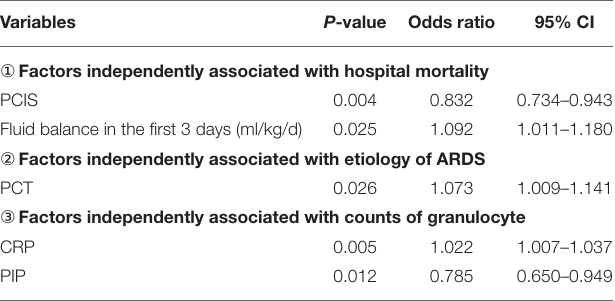
TABLE 5 | Results of multivariate analysis among three subgroups.